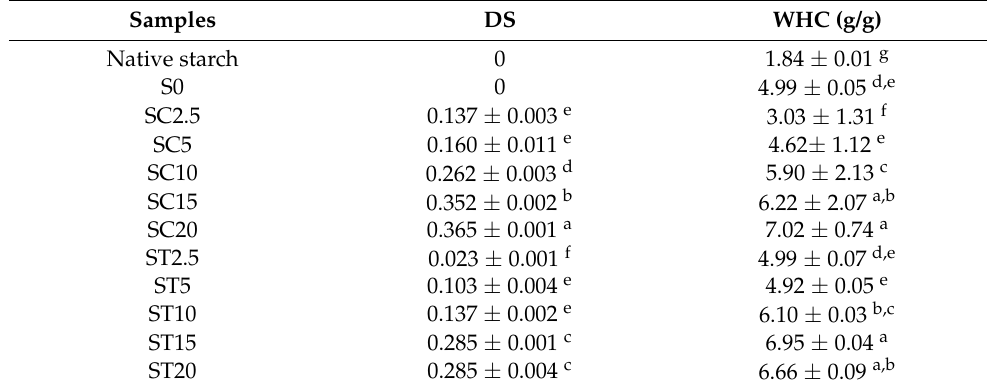
Table 1. Degree of substitution (DS) and water holding capacity (WHC) of native starch, control sample (S0) and starches hydrogels obtained by reactive extrusion.